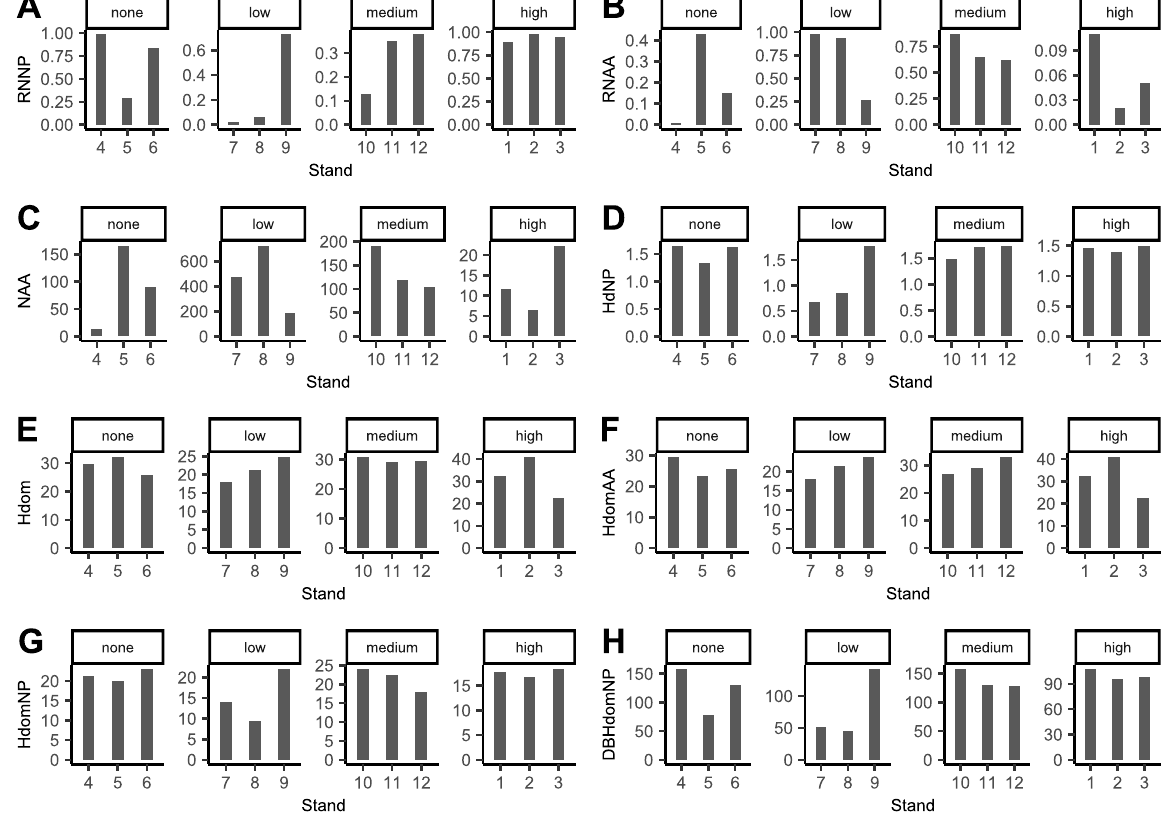
Fig. 9 Plot of stand variables in each stand that contribute significantly to